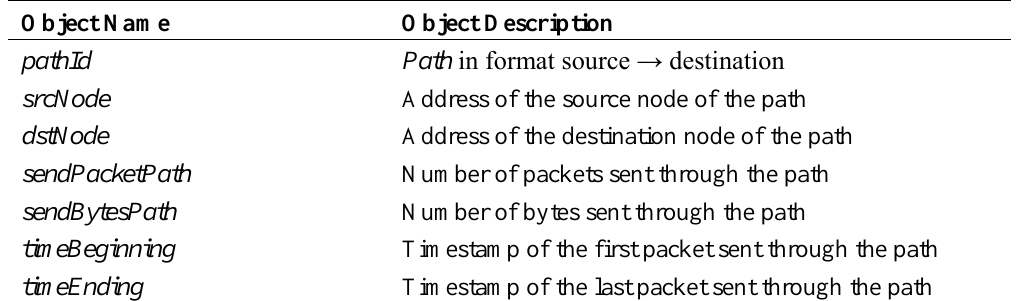
Table 4. Objects represented in the path Table .